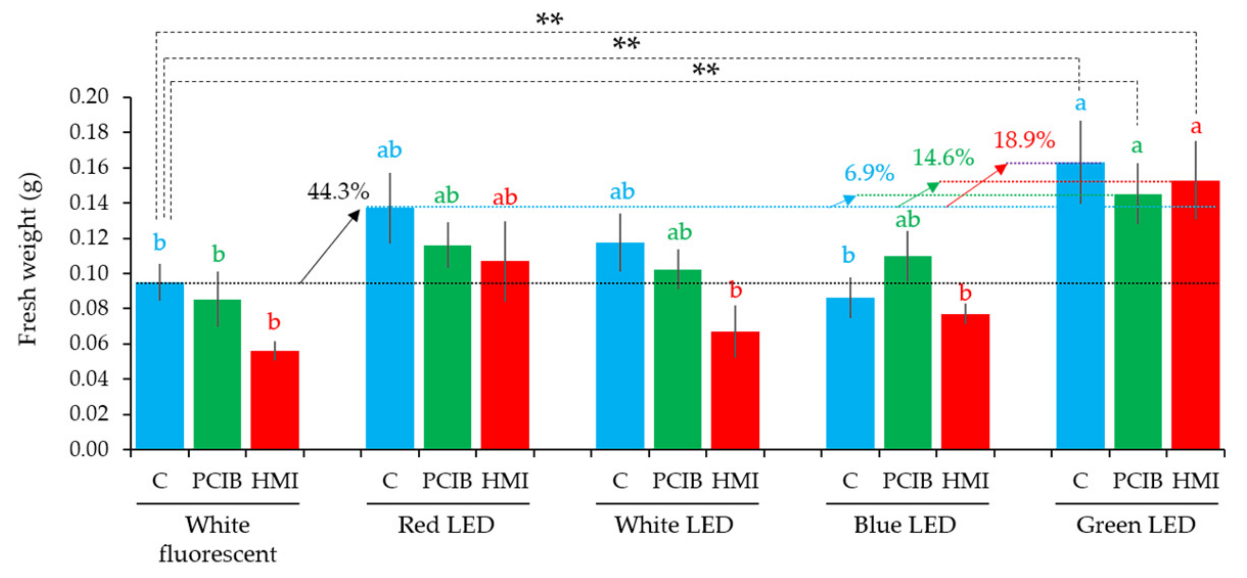
Figure 6. Fresh weight of D. okinawense under different LEDs using PCIB- and HMI-manipulated culture media. Blue, green, and red bars represent non-manipulated culture media (C), 0.01 mg/L PCIB ‐ manipulated culture media (PCIB), and 0.01 mg/L HMI ‐ manipulated culture media (HMI), respectively (total number of explants, n = 15). Values are means ± standard error (s.e.; n = 15). Up-ward arrows represent the percentage of increase from the respective horizontal lines. Black, light blue, green, red, and dark red dotted horizontal lines represent the average fresh weight in control under white fluorescent light, control under red LED, PCIB under green LED, HMI under green LED, and control under green light. Letters above the bars that share the same letter are statistically identical and those that do not are statistically different at p ≤ 0.05 using Tukey’s multiple comparison test (significance levels between the same color letters). Here, **; p ≤ 0.05 by student t ‐ test. Table 2. PLBs proliferation percentage (%), shoot formation percentage (%), and number of shoots regenerated under different LEDs.